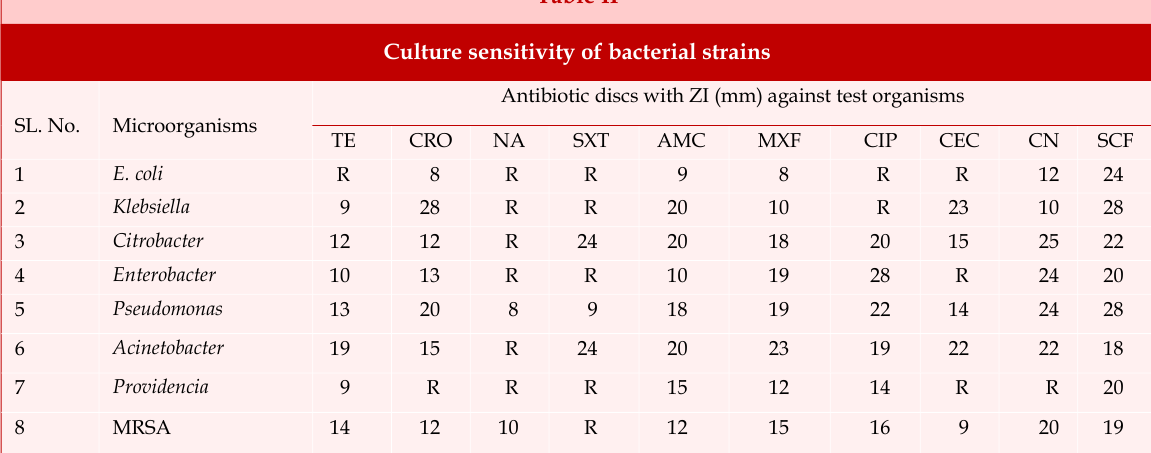
Culture sensitivity of bacterial